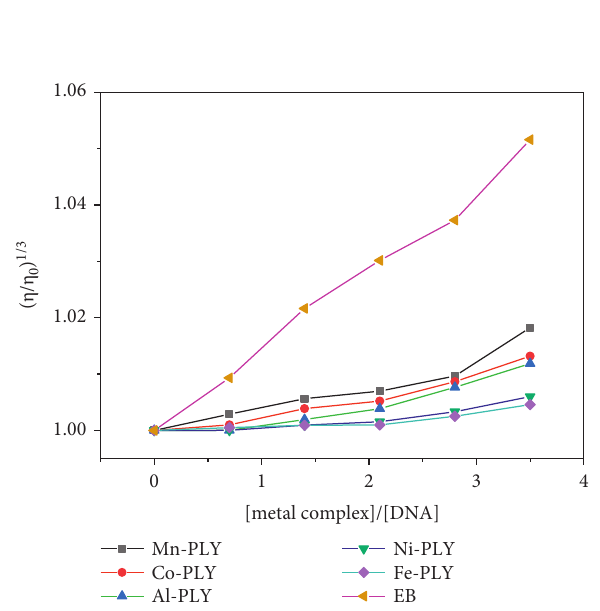
Figure 6: Effect of increasing amounts of the metal-PLY complexes on the relative viscosity of